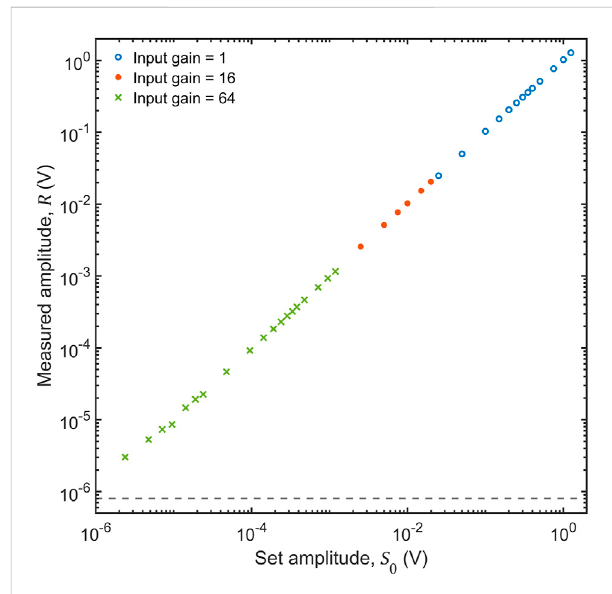
FIGURE 5 Measured amplitude R vs. input signal amplitude S 0 for 1 kHz sinusoidal input signals, using a fi xed reference frequency of 1 kHz. Thebluecircles,orangedotsandgreencrossesindicatedataobtained using time constants of 0.6, 3 and 6 s and nominal PGA input gainsof1,16and64respectively.Thedashedhorizontallineat0.81 µV represents the noise fl oor, using a 6-s time constant and a gain of